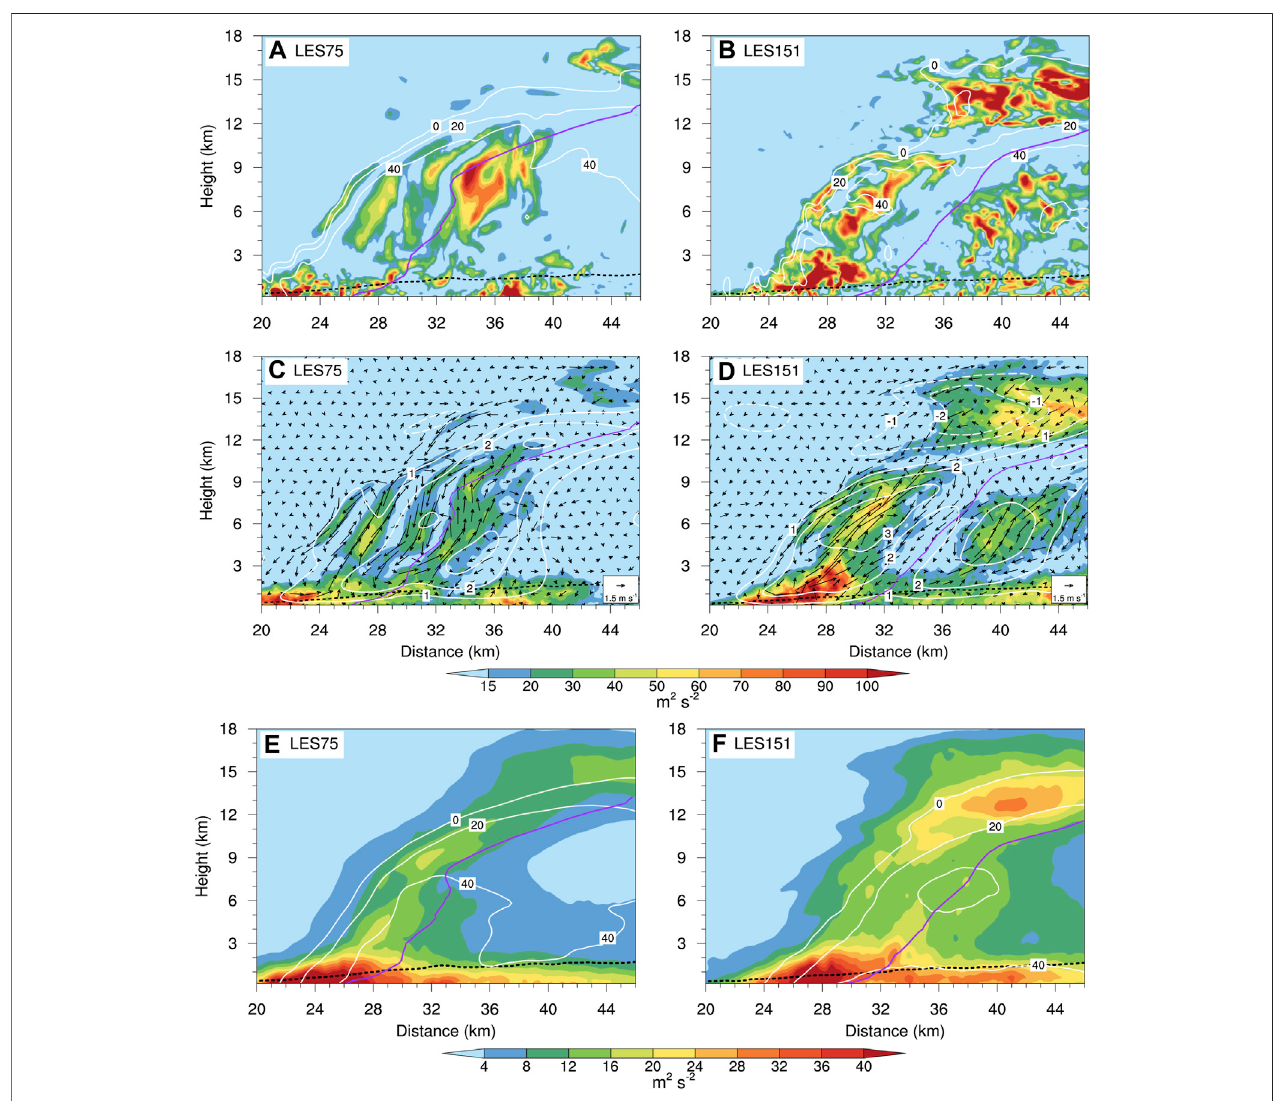
FIGURE 3 | (A, B) The radius-height cross sections of TKE (shading, units: m2 s-2) and radar re fl ectivity (contours, units: dBZ) simulated at 0300 UTC 18 July in LES75 (left) along the azimuth of 185 ° and at 0400 UTC 18 July in LES151 (right) along the azimuth of 188 ° with an interval of 20 dBZ. (C, D) The radius-height sector cross sections of TKE (shading), radial and vertical perturbation winds (vectors), and smoothed vertical motion (solid contours for upward motion and dashed contours fordownwardmotion),whichareaveragedover170 ° – 200 ° inLES75andaveragedover173 ° – 203 ° inLES151. (E,F) Sameas (A,B) ,butaveragedazimuthallyover the whole eyewall. The radius of maximum wind is indicated with the solid purple lines and the dashed black lines indicate the height of the in fl ow layer.